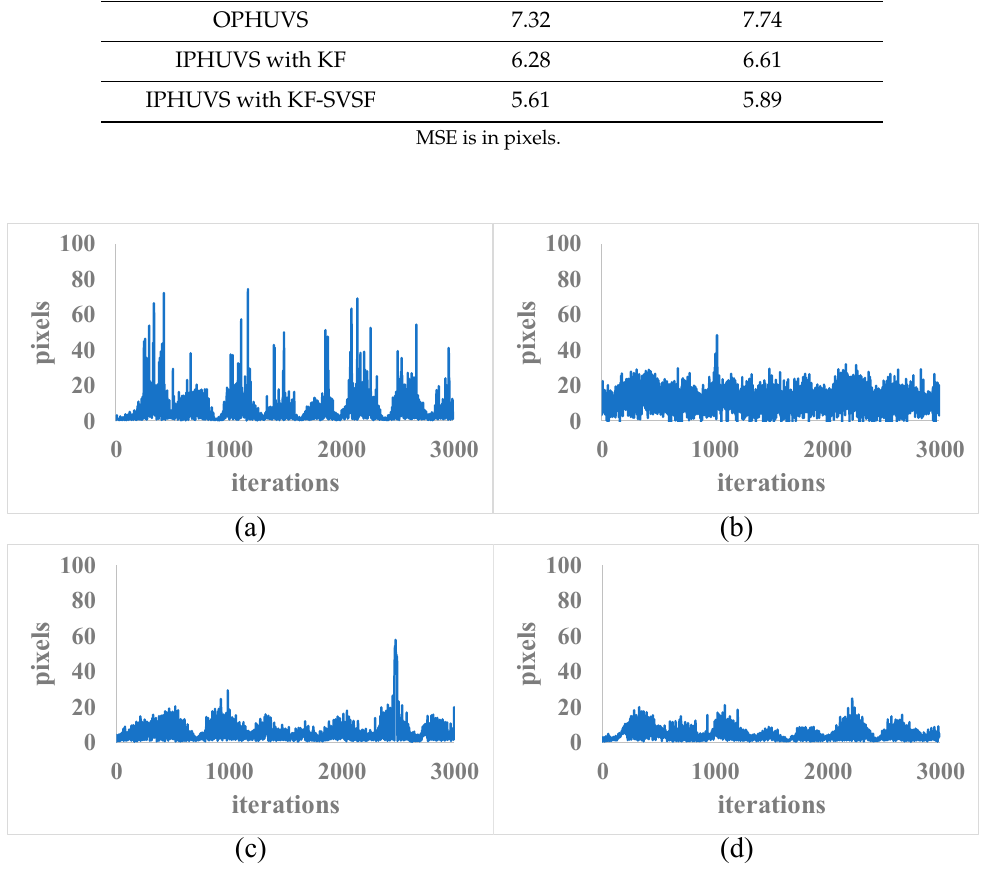
Figure 16. Image error of different strategies in the experiment of the double leaf rose path. ( a ) Image error of IBUVS. ( b ) Image error of the original PHUVS. ( c ) Image error of the improved PHUVS with the KF method. ( d ) Image error of the improved PHUVS with the KF-SVSF method.